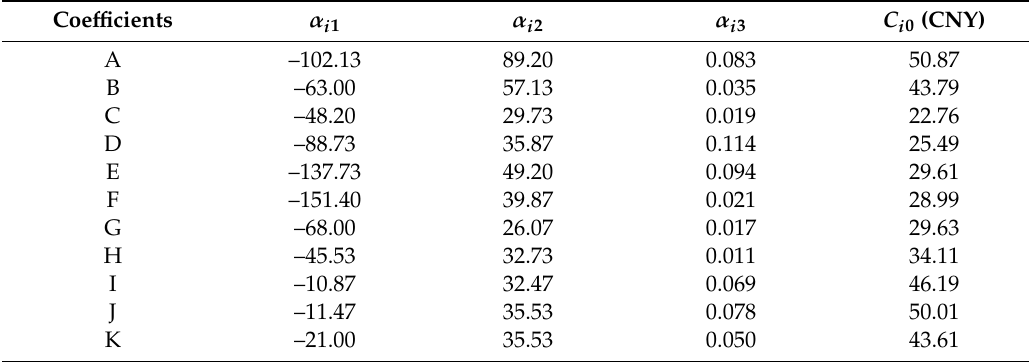
Table 2. Coe ffi cients of manufacturing cost